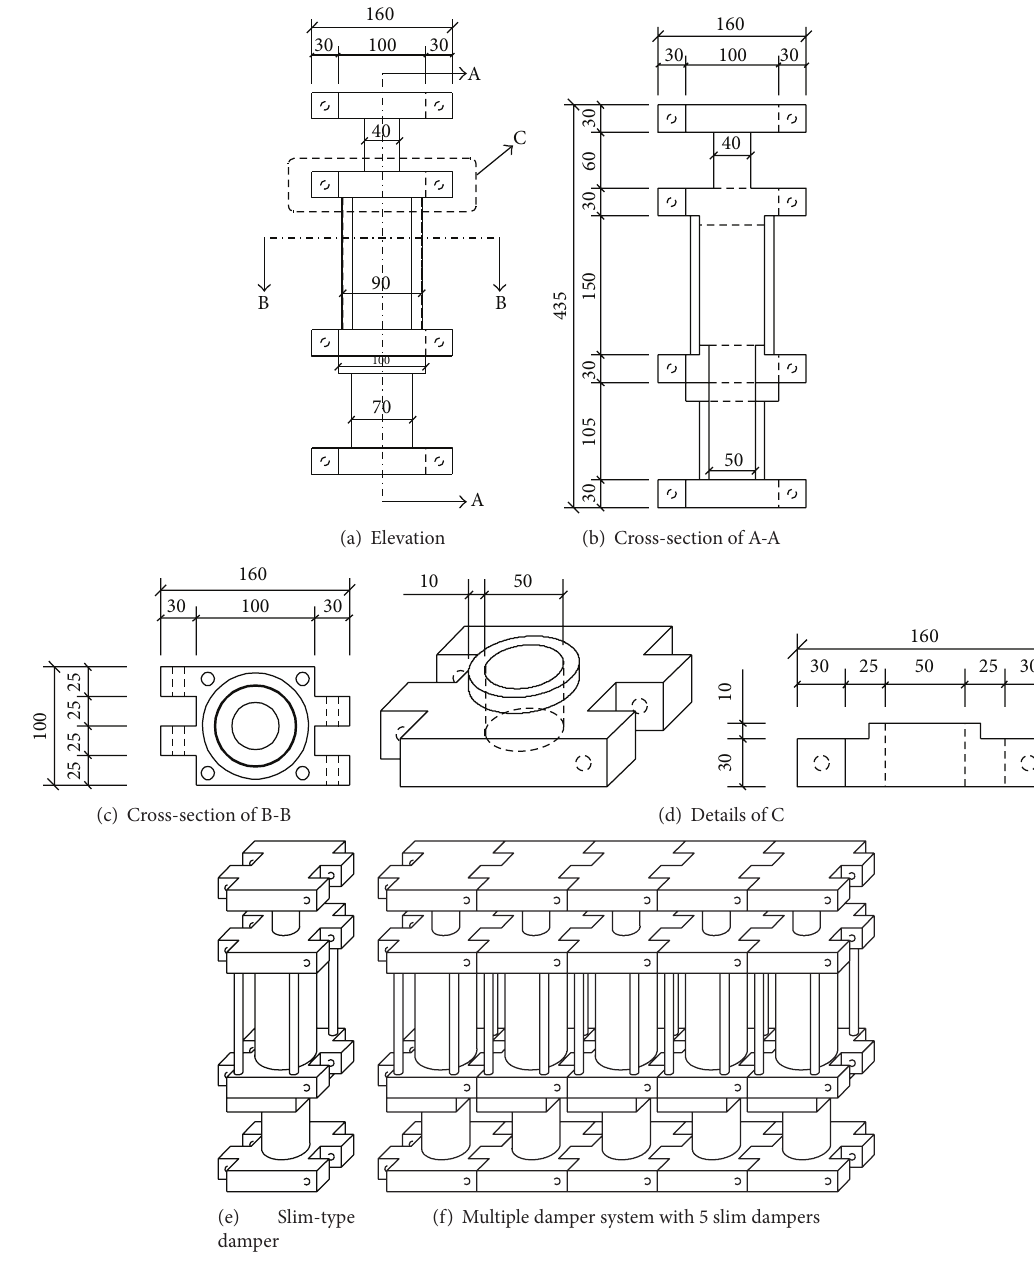
Figure 1: Drawings of multiple slim-type dampers.